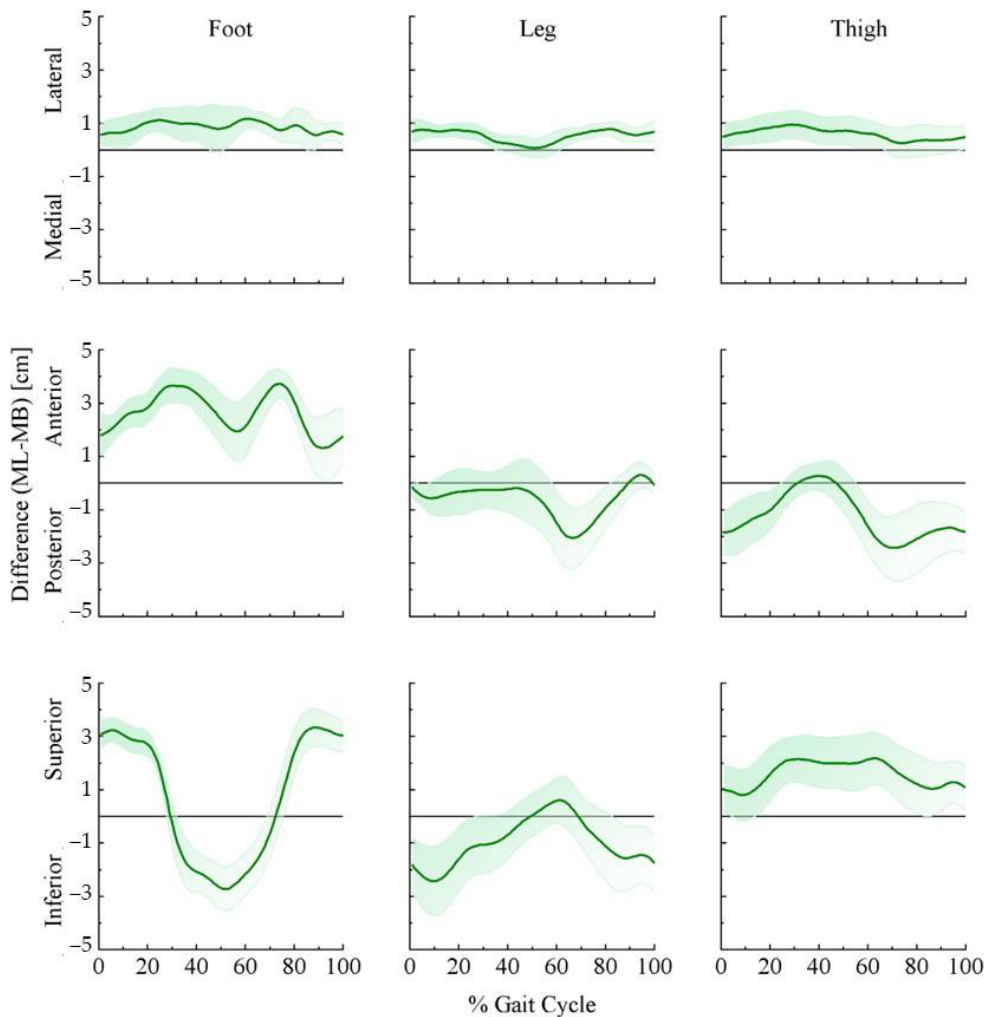
Figure 4. Ensemble curve of lower extremity segment center of mass differences between marker- based and markerless motion capture systems across the average 10 stride cycles for 16 participants. Differences were estimated as markerless (ML) center of mass position—marker-based (MB) center of mass position.